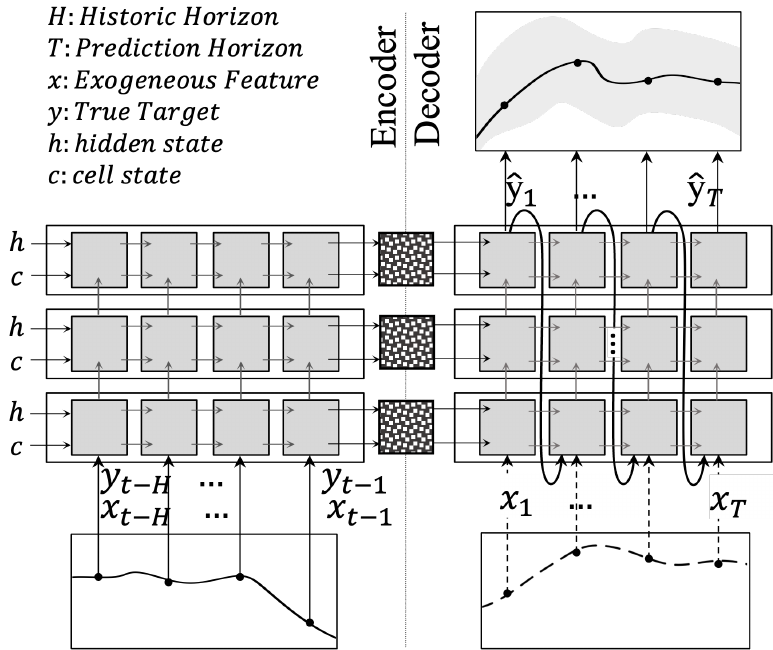
Figure 2. Exemplary unfolded encoder-decoder architecture of sequence-to-sequence RNN. We pass inputs on both the encoder and decoder sides. The number of the layer stack is subject to parameterization. The gray boxes represent RNN